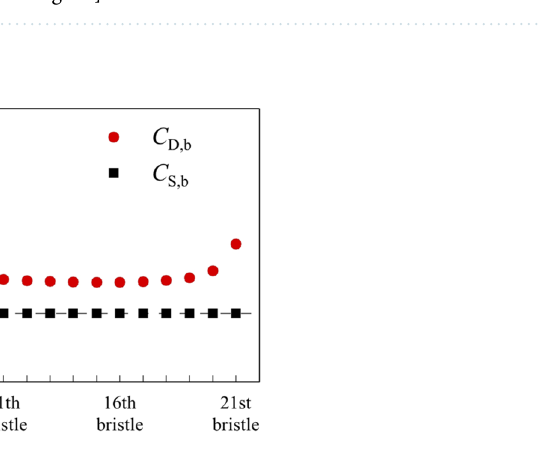
Figure 7. The plot of non-dimensional velocity vectors around the leading edges of two flat-plate wings [first 15% of the two flat-plate wings shown in Fig. 5b].